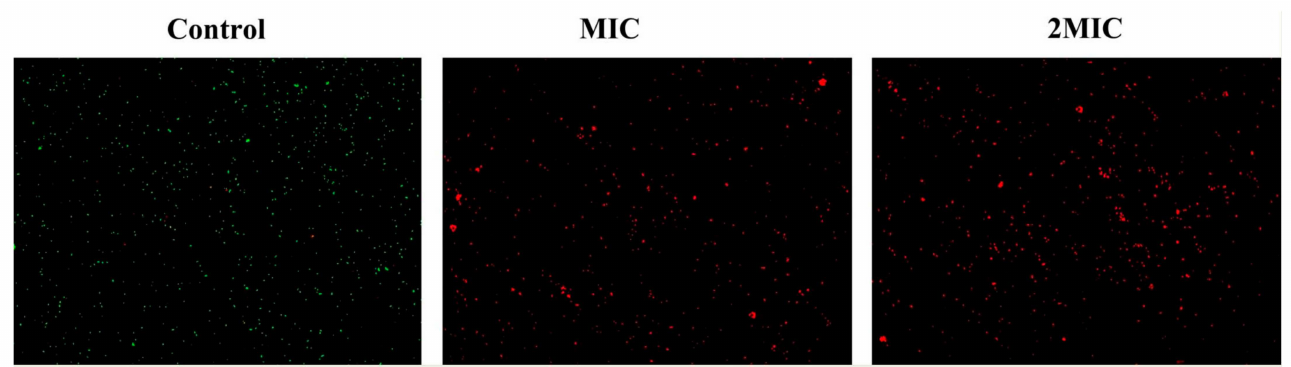
Figure 3. Observation of the effect of shikonin on the cell membrane integrity of strain ATCC29213 by laser confocal microscope (100 ×